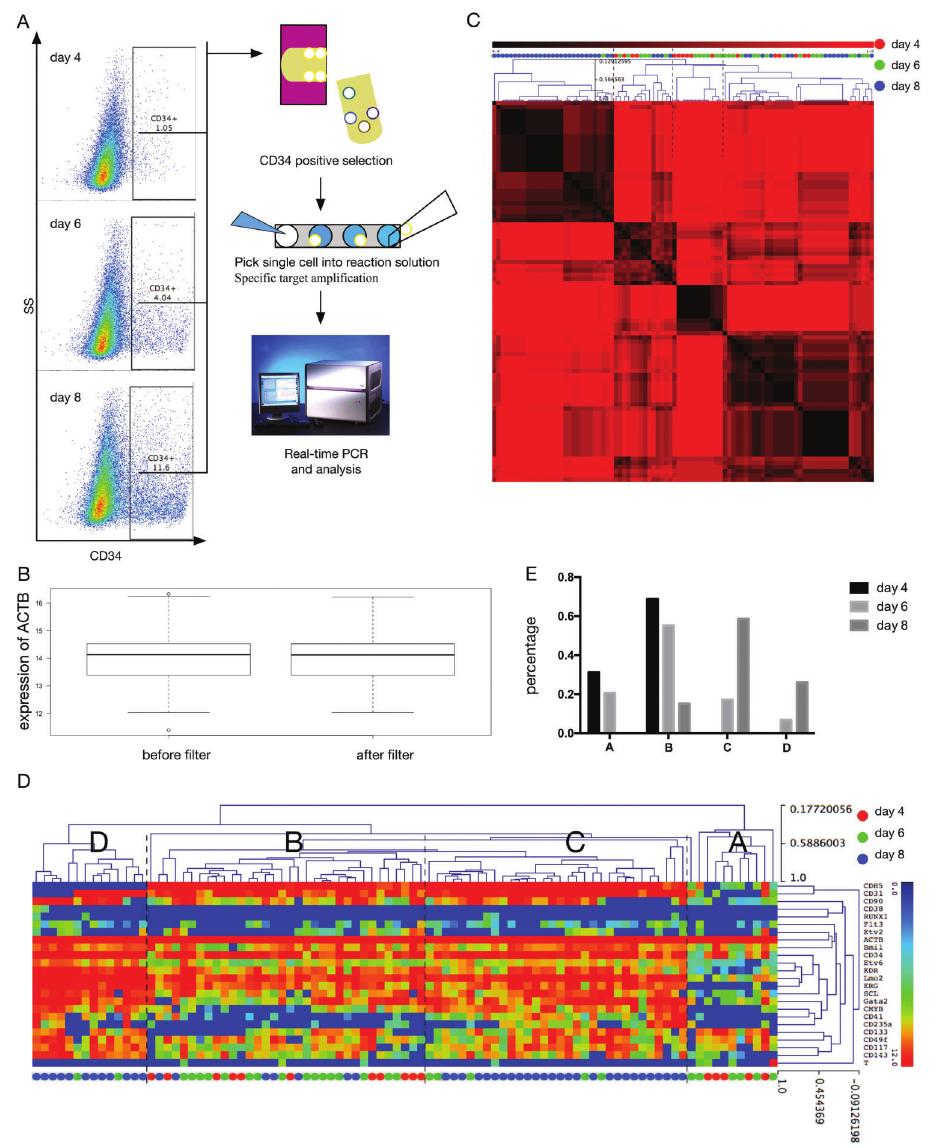
Figure 2. Single-cell gene expression analysis of CD34 + cells derived from H1/OP9 coculture system. A, Process fl ow diagram of single-cell gene expression analysis. Individual CD34 + cells were collected at days 4, 6, and 8. B, Samples were fi ltered based on the expression level of ACTB (log2 gene expression=30-Ct); outliers were removed. C, Heatmap of NMF showing cell-to-cell correlation. Red, green, and blue circles of each column correspond to individual CD34 + cells from days 4 (n=16), 6 (n=29), and 8 (n=46), respectively; rank is 4. D, Heatmap of hierarchical clustering showing 4 clusters (A, B, C, and D) of CD34 + cells. Red, green, and blue circles of each column correspond to individual CD34 + cells from days 4, 6, and 8, respectively. Each row corresponds to a speci fi c gene. Color scale was set from 0 to 12. Blue to green suggests low to moderate gene expression (log2) and green to red suggests moderate to high gene expression (log2). E , Distribution of samples (days 4, 6, and 8) in cluster A, B, C, and